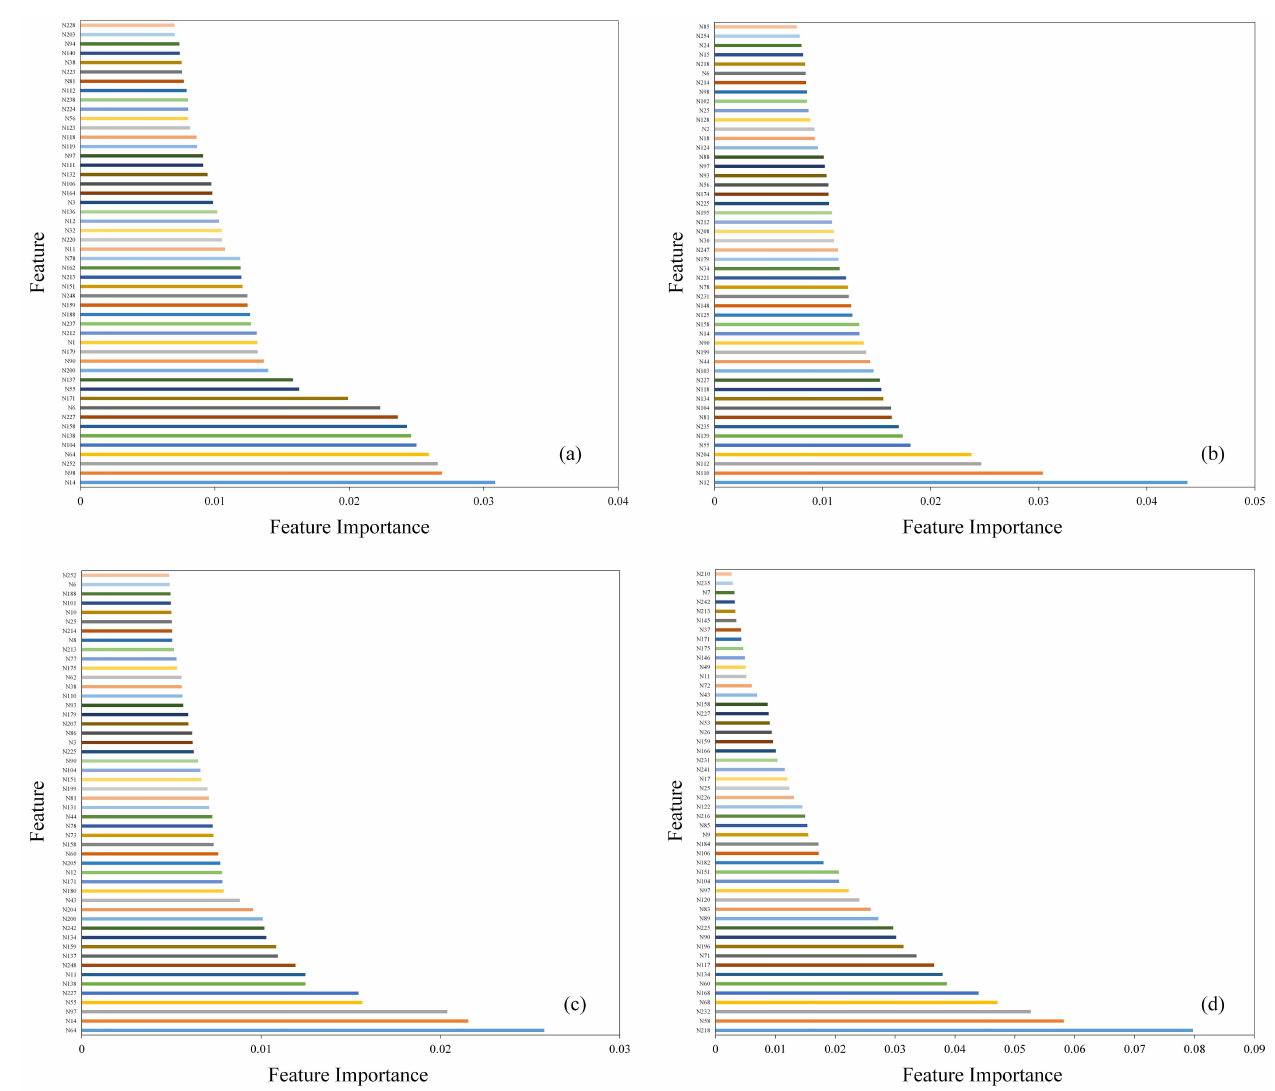
Figure 4. Feature optimization using different algorithms, including ( a ) AdaBoost, ( b ) CatBoost, ( c ) RF, and ( d )